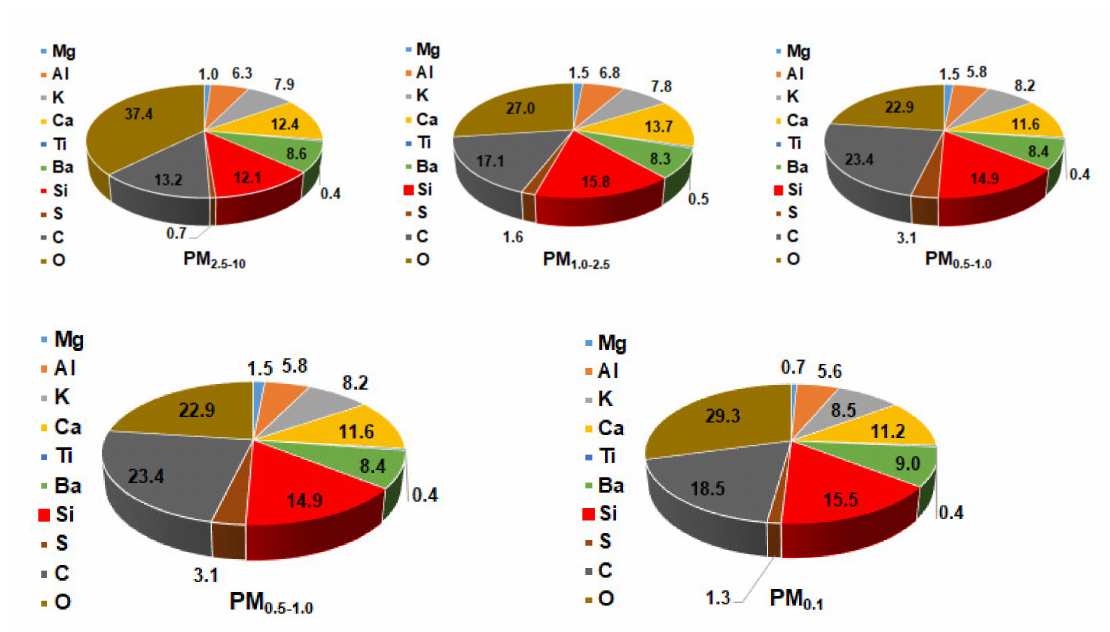
Figure 6. Elemental composition of outdoor PM 2.5–10 , PM 1–2.5 , PM 0.5–1 , PM 0.1–1 , and PM 0.1 collected during the class at